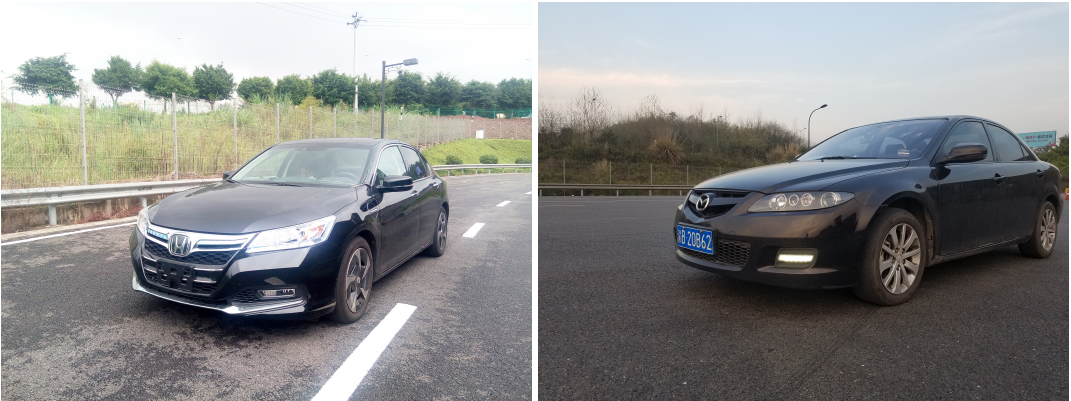
Figure 2. The testing vehicle: PHEV vehicle ( left ) and gasoline vehicle ( right ).